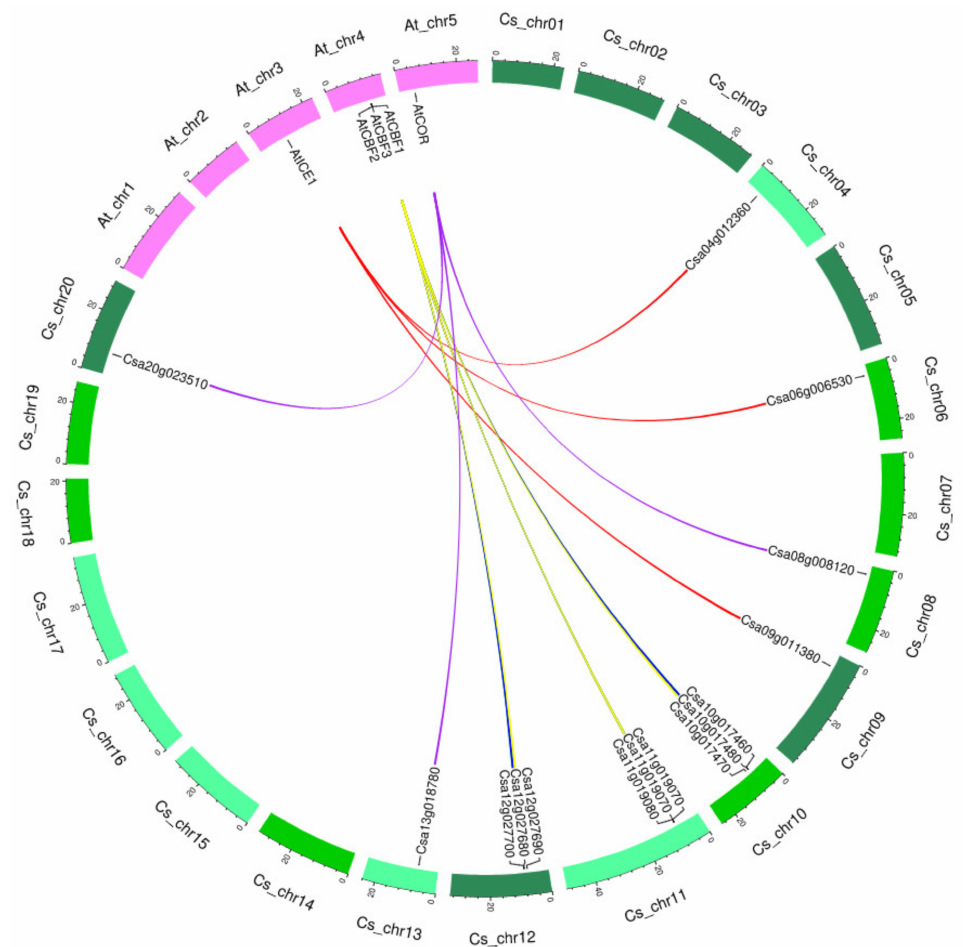
Figure 3. Synteny analysis of the selected ICE-CBF-COR genes in A. thaliana and C. sativa . The At_chr and Cs_chr show the chromosome number in A. thaliana and C. sativa , respectively. Three sub-genomes of C. sativa represent in different green